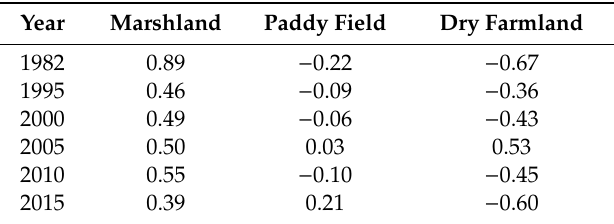
Table 8. The grading scores for landscape type stability.